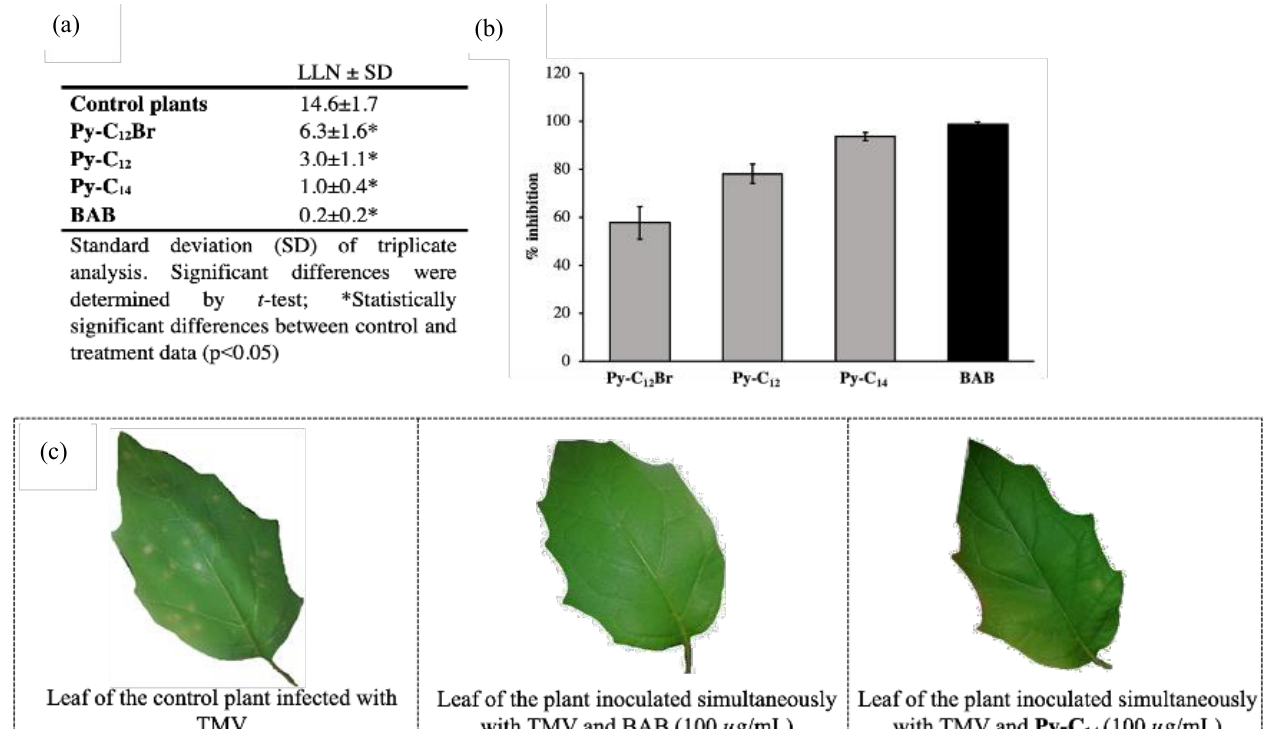
Figure 1. ( a ) Number of local lesions (LLN) on leaves of treated and control Datura stramonium plants. Treated plants were simultaneously inoculated with Tobacco mosaic virus (TMV) and tested compounds. ( b ) Percentage of inhibition of LLN for the tested QAS and BAB. Error bars show standard deviation of triplicate analyses. ( c ) Local symptoms of TMV infection on leaves of control plants and plants inoculated with TMV and BAB or TMV and Py-C 14 .